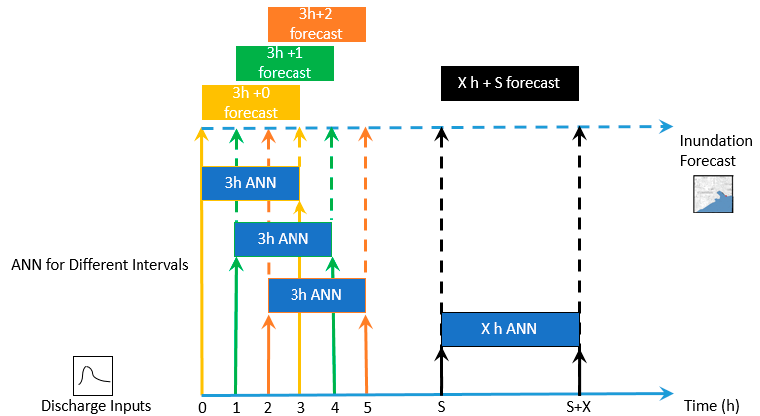
Figure 3. Shift of ANN forecast models for multistep forecast intervals. The yellow color shows the forecast of the first interval (forecast interval same as the training interval, i.e., at time 0). The green color shows applying the original 3 h forecast network for 1 h later forecast from 1–4 h. The orange color shows applying the original 3 h forecast network for 2 h later forecast from 2–5 h. The black box shows the general case of applying the original X h forecast network for S h later forecast, from S h to X h + S.